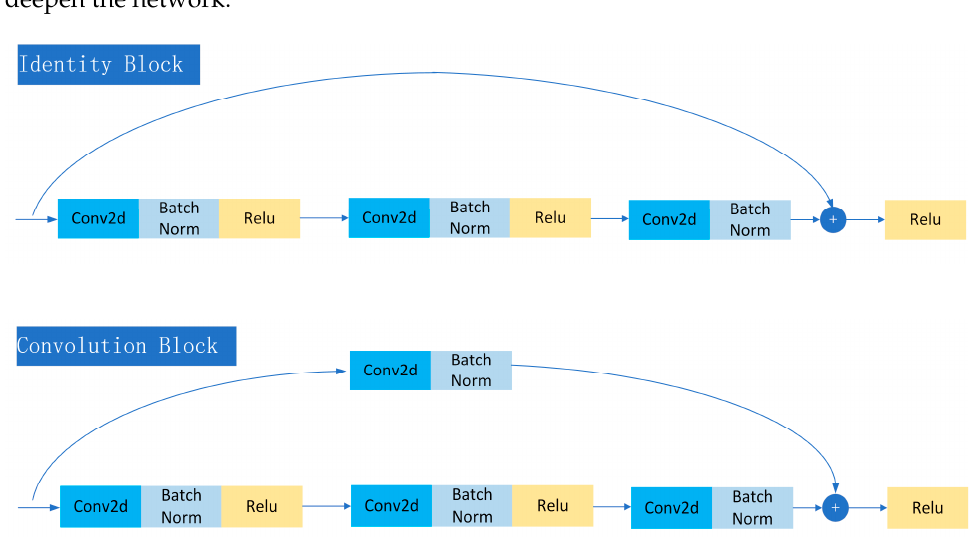
Figure 6. Two important basic blocks in the residual network structure.